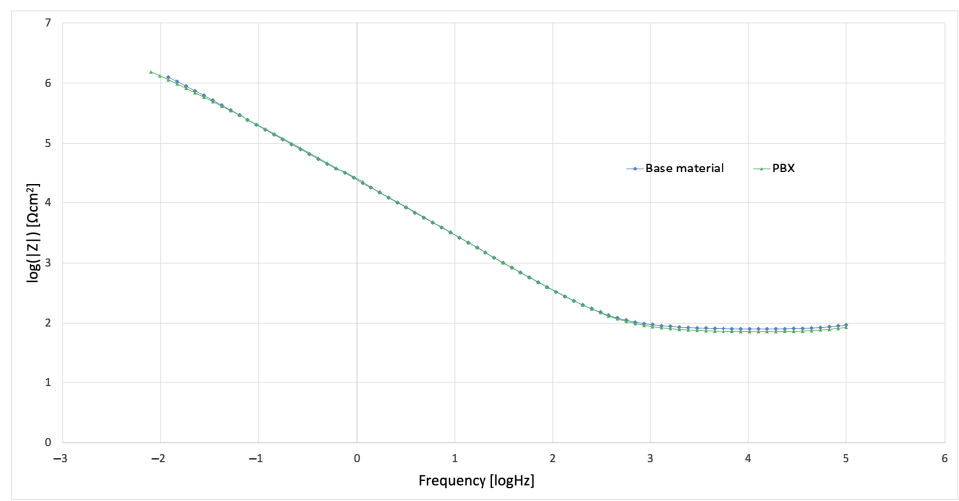
Figure 14. Bode summary plot for |Z| for the tested samples .